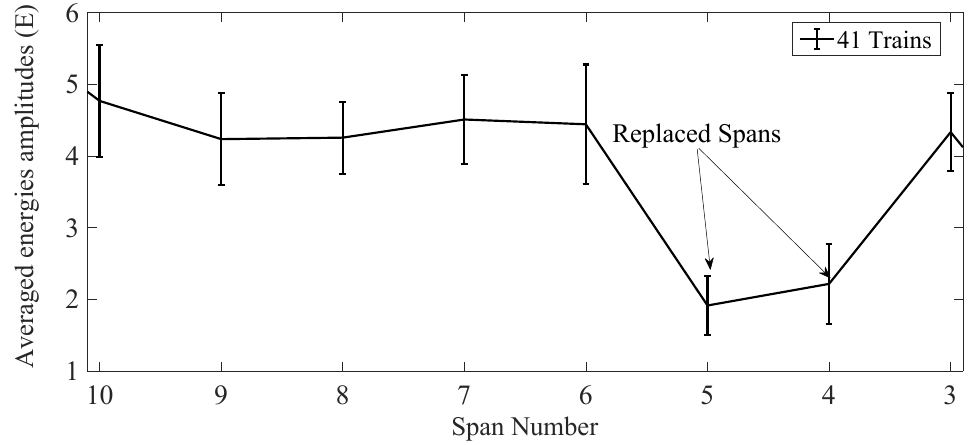
Figure 15. Sum of averaged energies per span using a mean and standard deviations from 41 train runs.